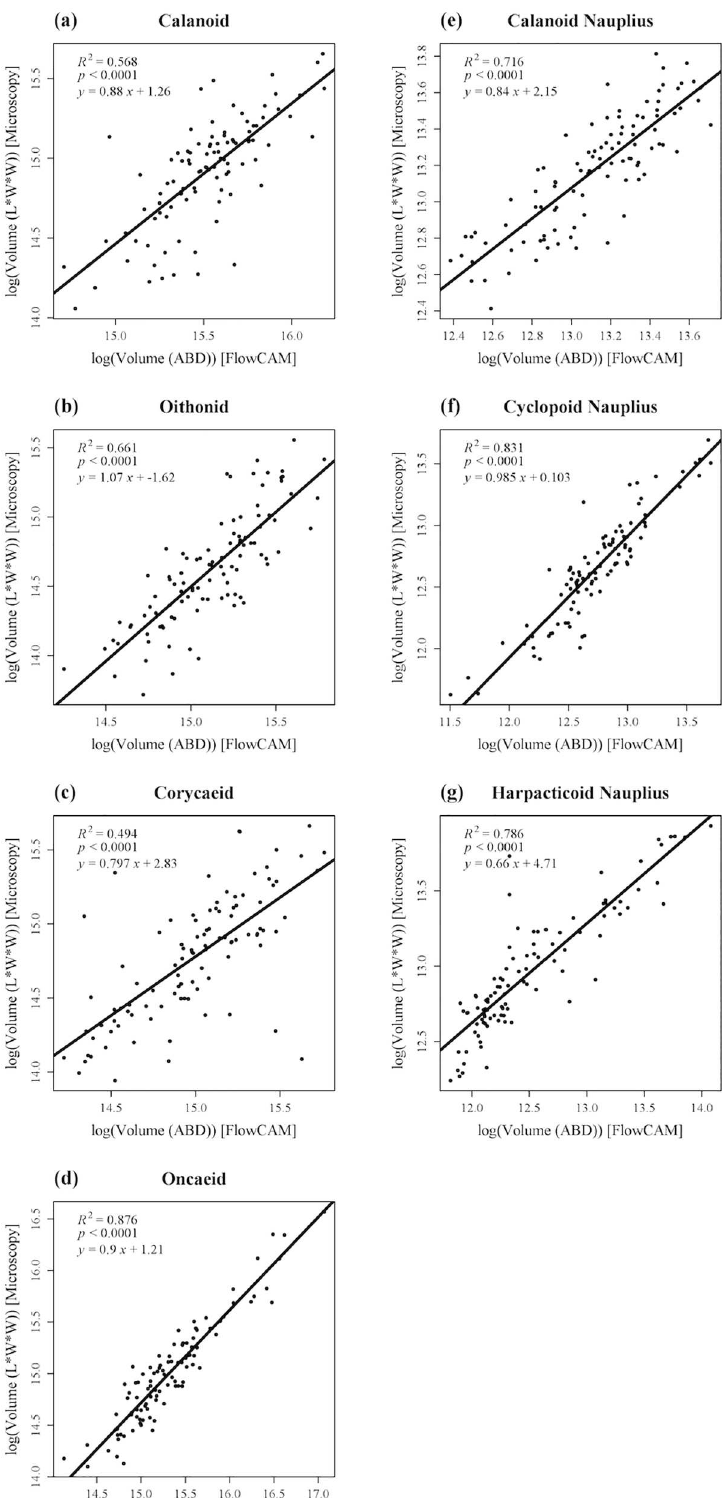
Fig 5. Scatter plots illustrating the relationships between the biovolumes estimated with Area-Based- Diameter(V ABD ) from the FlowCAM versus the manual image measurements using ruler tools for